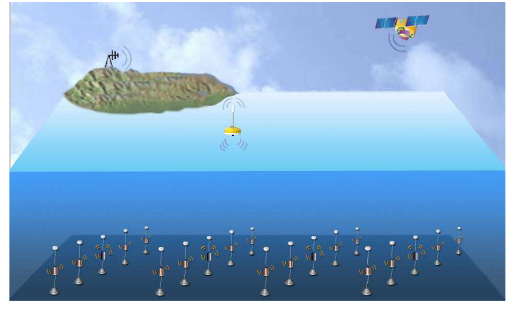
Figure 6. Underwater acoustic sensor networks.